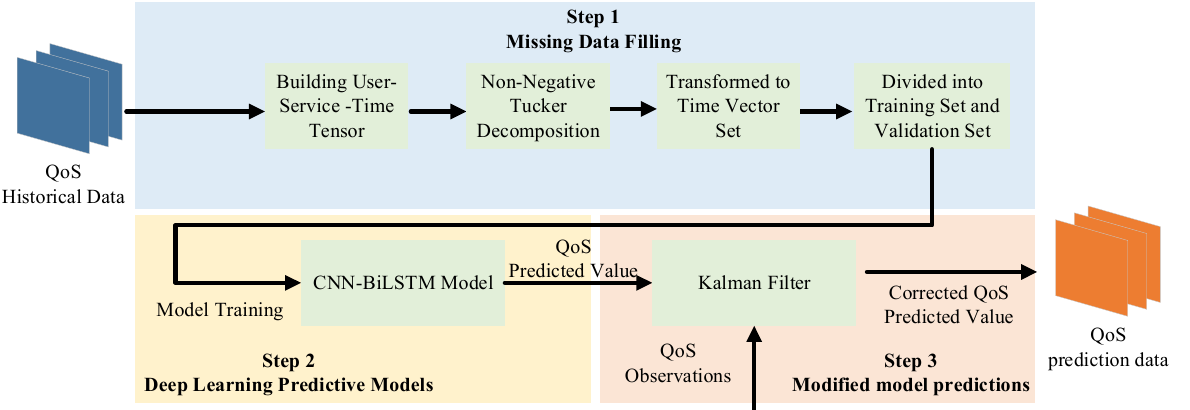
Figure 3. General structure of the MFDK model.